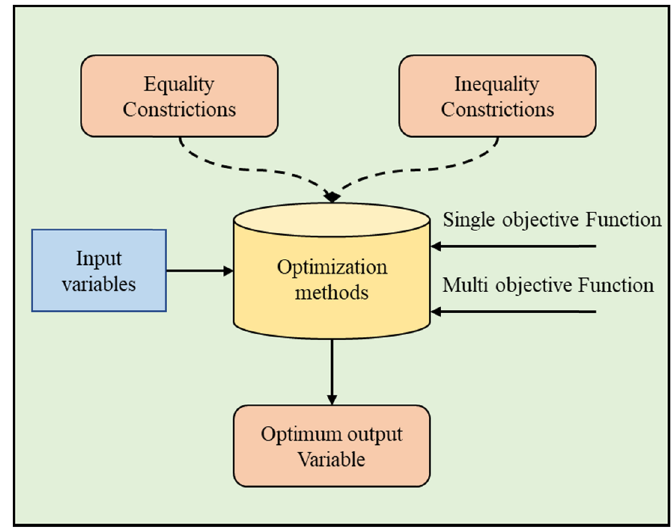
Figure 1: A typical DG